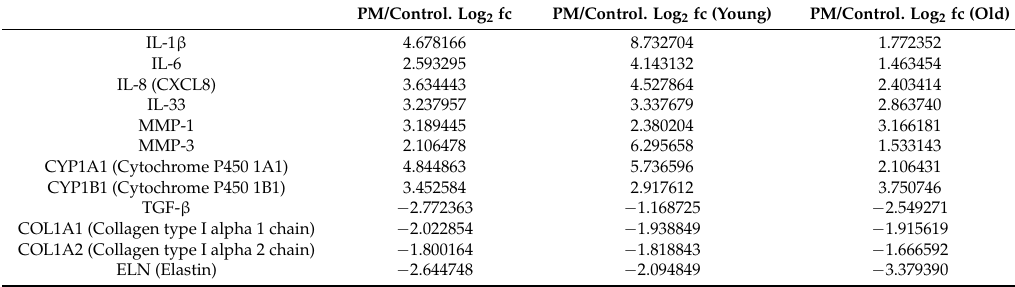
Table 2. Major genes which were overall differently expressed (greater than 1.5-log 2 folds up and down and a raw p -value < 0.05) in PM-exposed HDFs compared to their control fibroblasts ( n = 8 sample pairs, all from non-sun exposed areas, ages 9–94 years old, average 40.5) (PM/control. Log 2 fc) are shown. The impact of PM on the gene expression of young ( n = 4 sample pairs, ages 9–11, average 10.2) (PM/control. Log 2 fc (young)) and old ( n = 4 sample pairs, ages 55–94, average: 70.5) HDFs (PM/control. Log 2 fc (old)) are also separately presented. Differentially expressed genes were analyzed using the estimates of abundances for each gene in samples. Genes were excluded if they had at least one zero FPKM values in the samples. To facilitate log 2 transformation, 1 was added to each FPKM value of filtered genes. Filtered data were log 2 -transformed and submitted to quantile